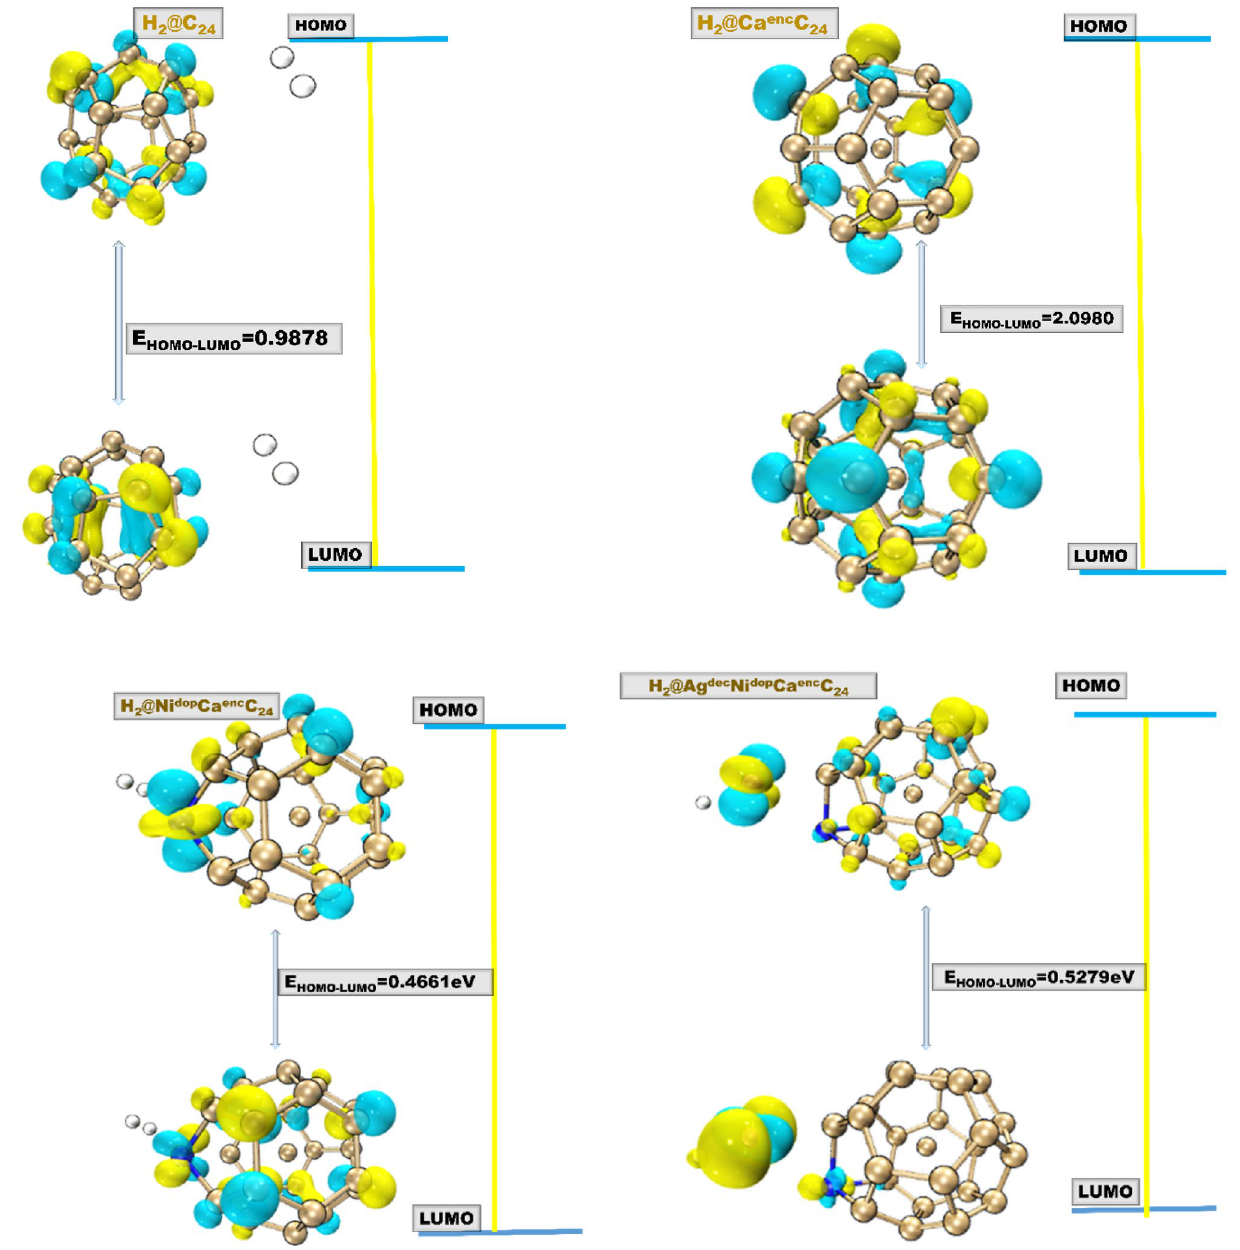
Figure 2. HOMO–LUMO distribution of the studied hydrogen adsorbed systems, with their significant HOMO–LUMO energy gap (E gap